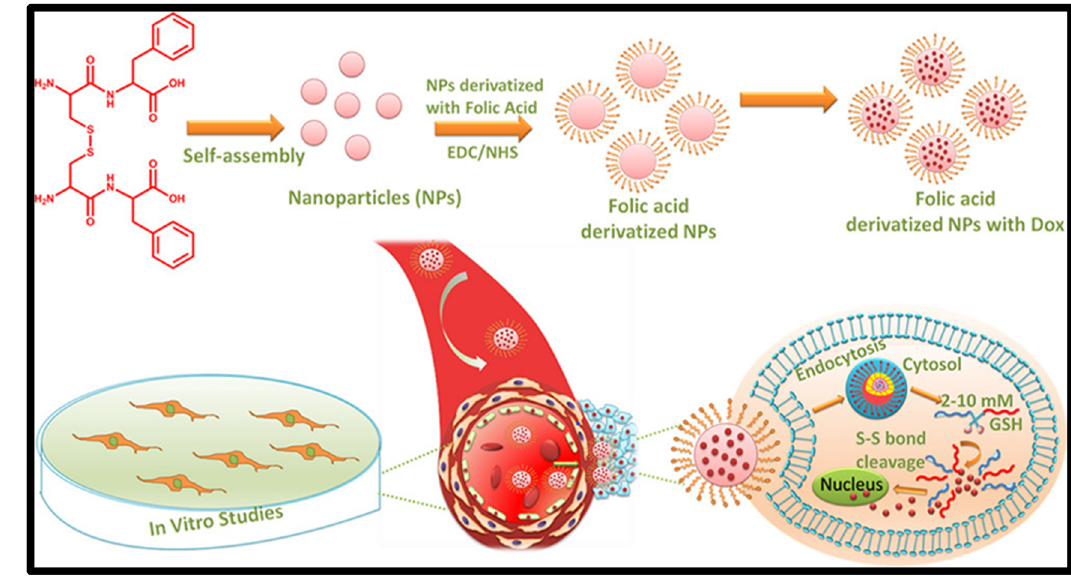
Figure 4: Schematic representation for the disul fi de - linked oxidized cysteine - phenylalanine nanoparticles drug